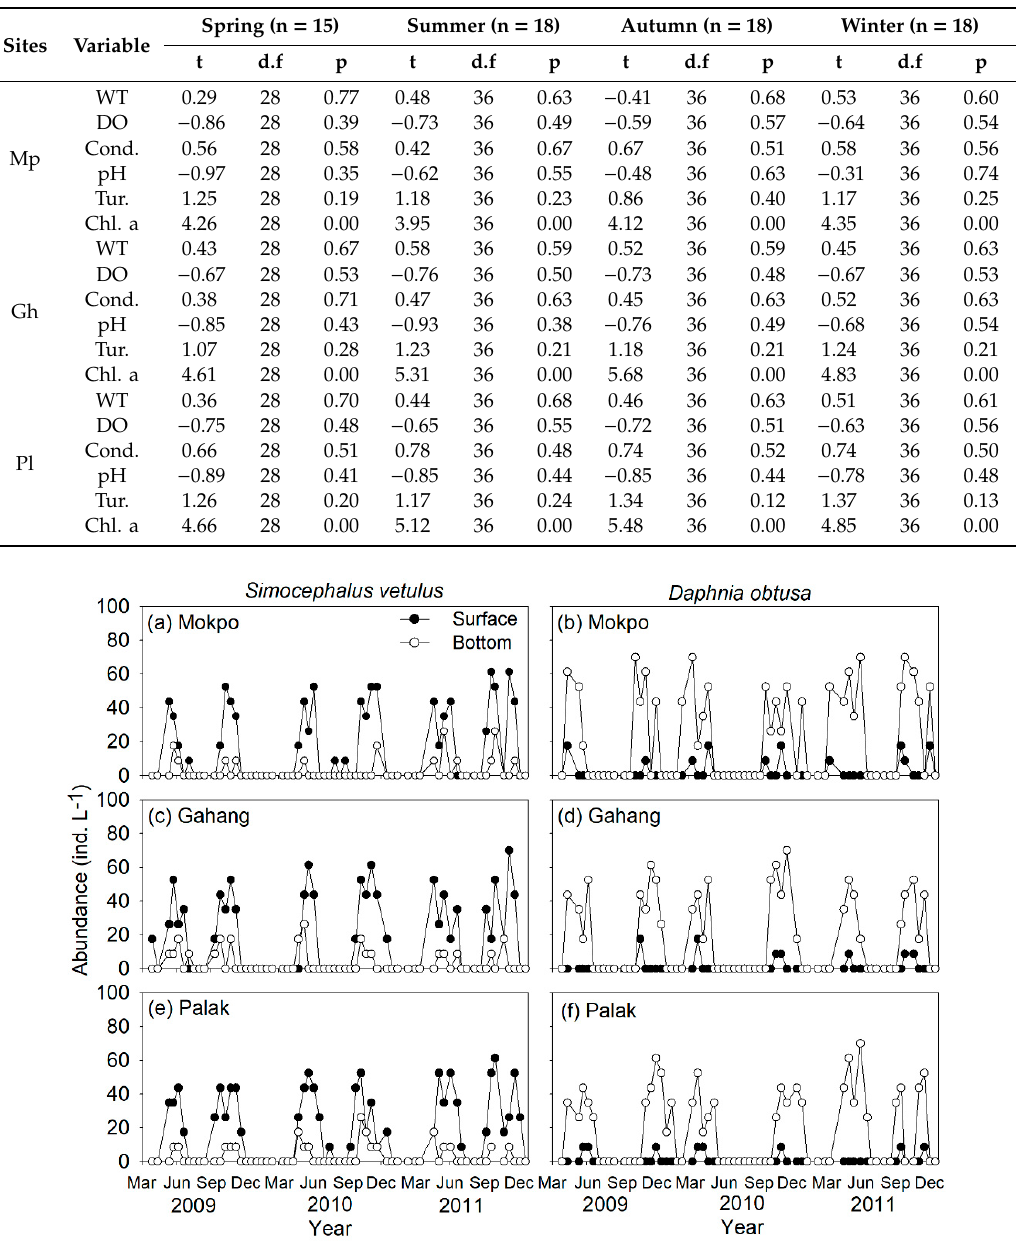
Table 2. T-test results to compare difference of environmental variables between surface and bottom layer. WT, water temperature ( ℃ ); DO, percent of (%) dissolved oxygen; Cond., conductivity (µS/cm); Tur., turbidity (NTU); Chl.a, chlorophyll a (µg/L). d.f, degrees of freedom. Mp, Mokpo; Gh, Gahang; Pl, Palak Wetland.